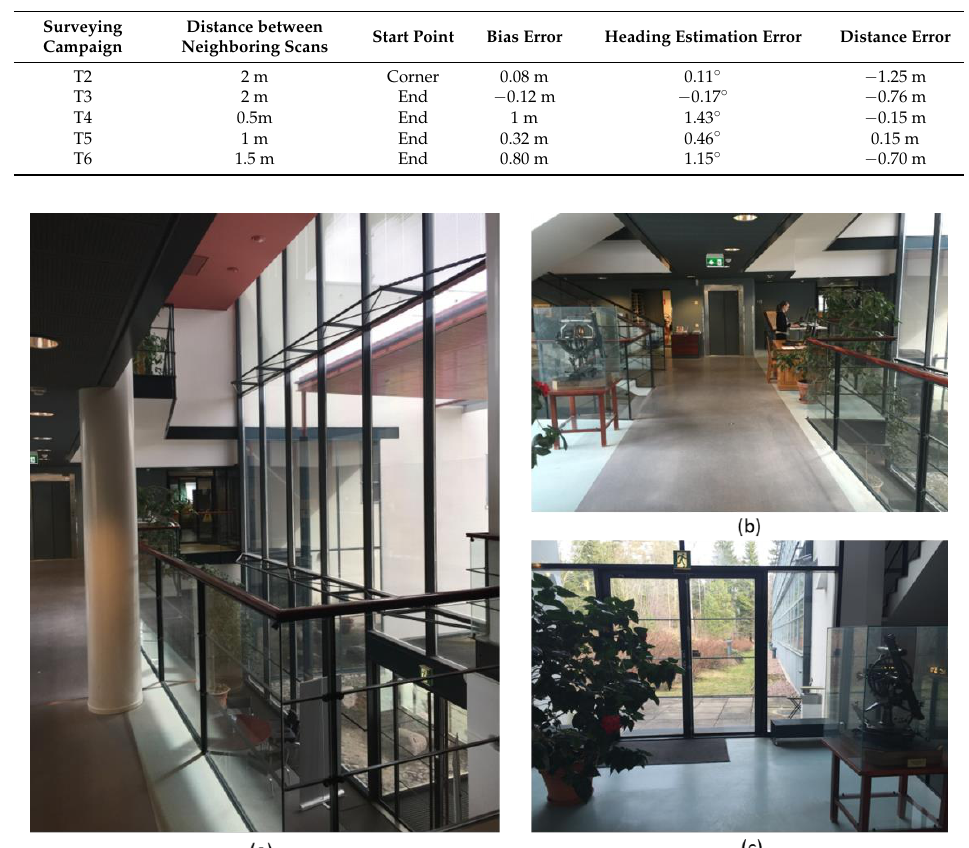
Table 5. Matterport mapping results with different setting.